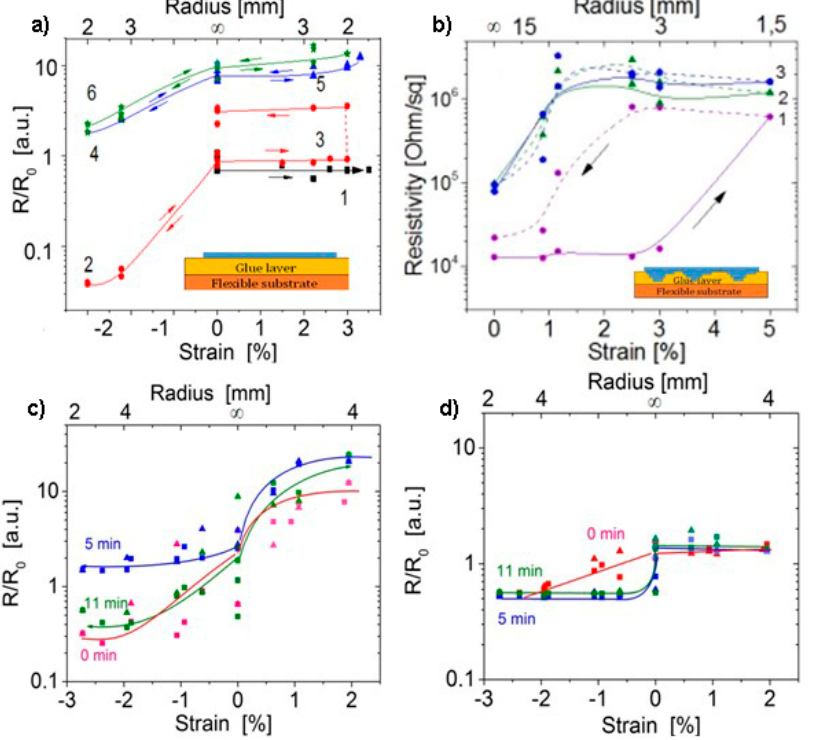
Figure 4. Changes in the resistivity under the tensile ( + ) and compressive (-) strain due to the bending of ( a ) fluorinated graphene (the fluorination time was 10 min) and ( b – d ) fluorinated MG on PET. Initial resistances were ( a ) R 0 = 2.0 kOhm, ( c ) R 0 = 67 kOhm / sq, ( d ) R 0 = 10 3 kOhm / sq. ( a , b ) The sequence of deformations and measurements is indicated by numbers. The fluorination time is given in ( c , d ) at the curves as a parameter. Inserts in ( a ) and ( b ) presents a sketchy image of the tested structures.